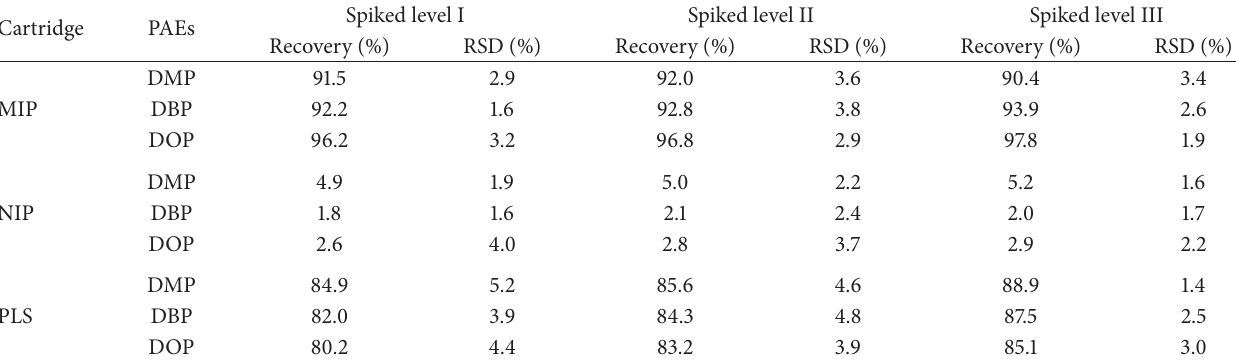
Table 2: Recoveries of PAEs in spiked beverages by MIP, NIP, and PLS cartridges in three spiked samples ( 𝑛 = 5 ).